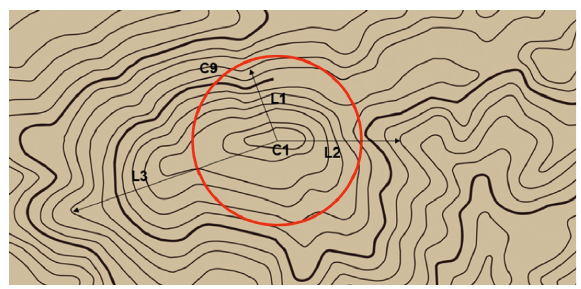
Figure 3: The contour line map.